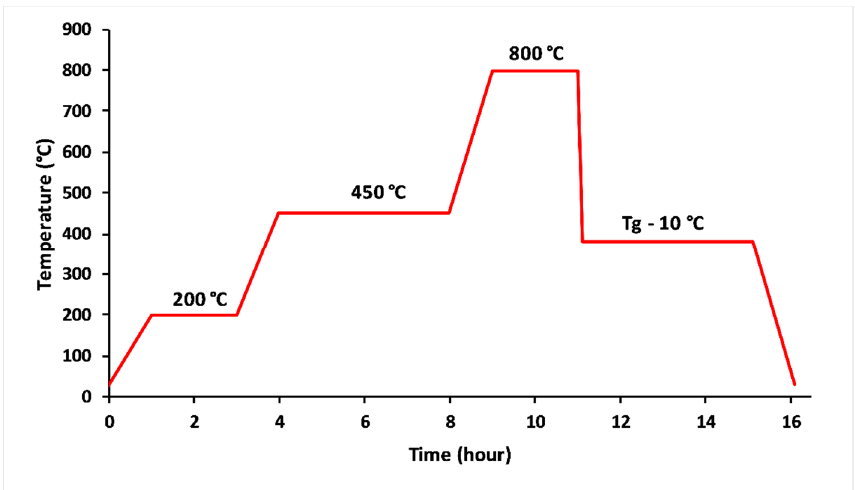
Figure 1. Thermal profile used to elaborate 3P 2 O 5 -2K 2 O-(1 − x)CaO-xMgO glasses.